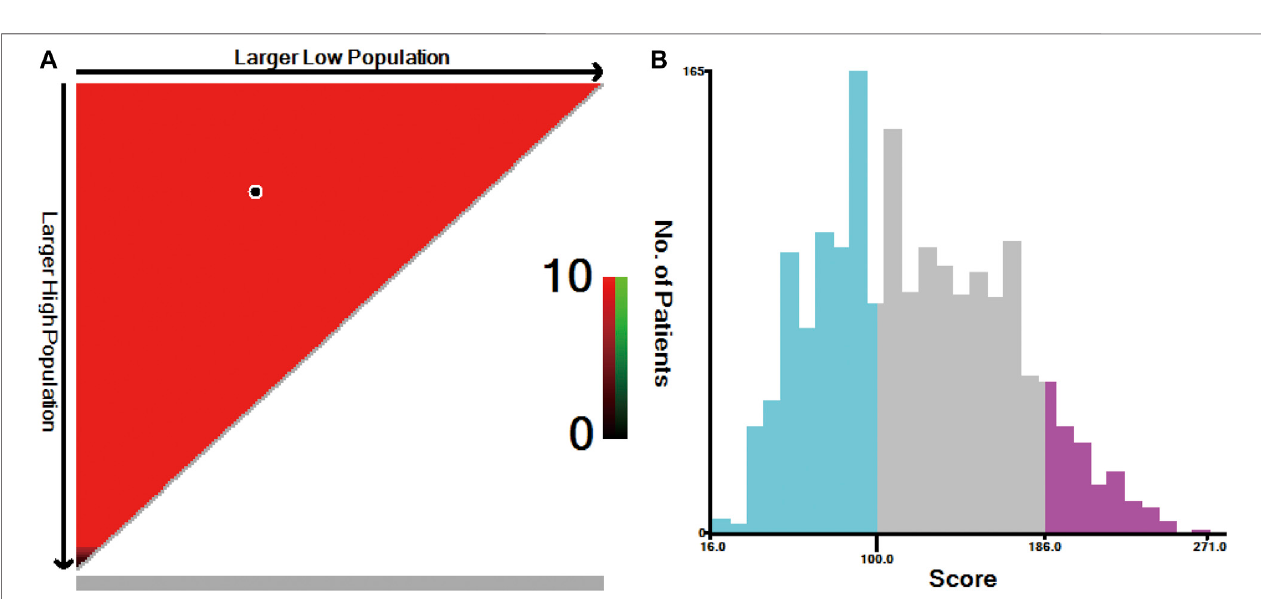
FIGURE 6 | X-tile analysis for risk strati fi cation: (A) The optimal cut-off value; (B) Numbers of patients in low, moderate and high risk subsets.